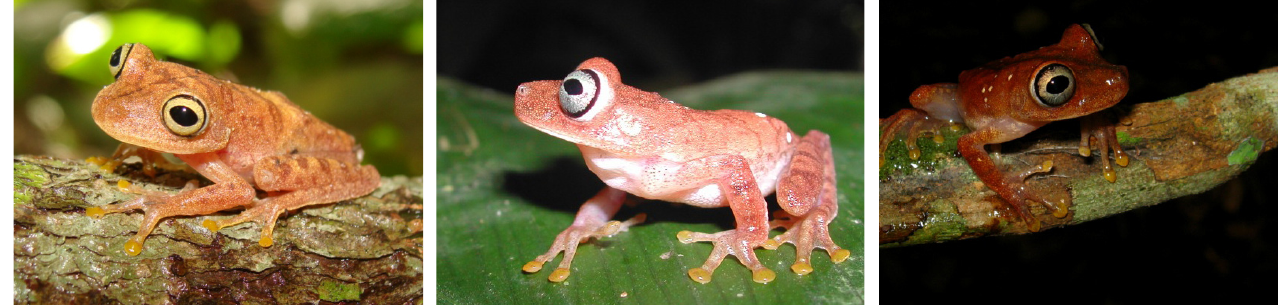
Figure 1. Hypsiboas